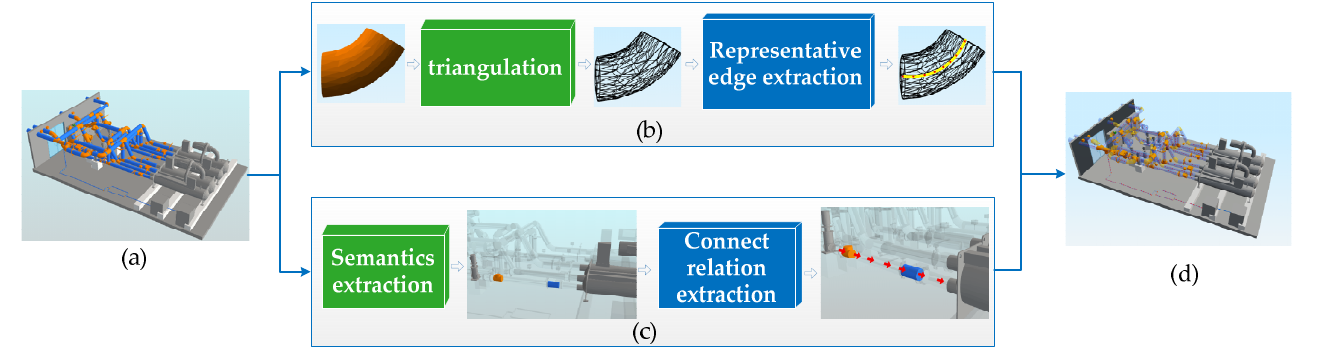
Figure 5. Framework of our proposed method: ( a ) an MEP system; ( b ) representative edge extraction; ( c ) directed identification; ( d ) an intelligent MEP monitoring system.